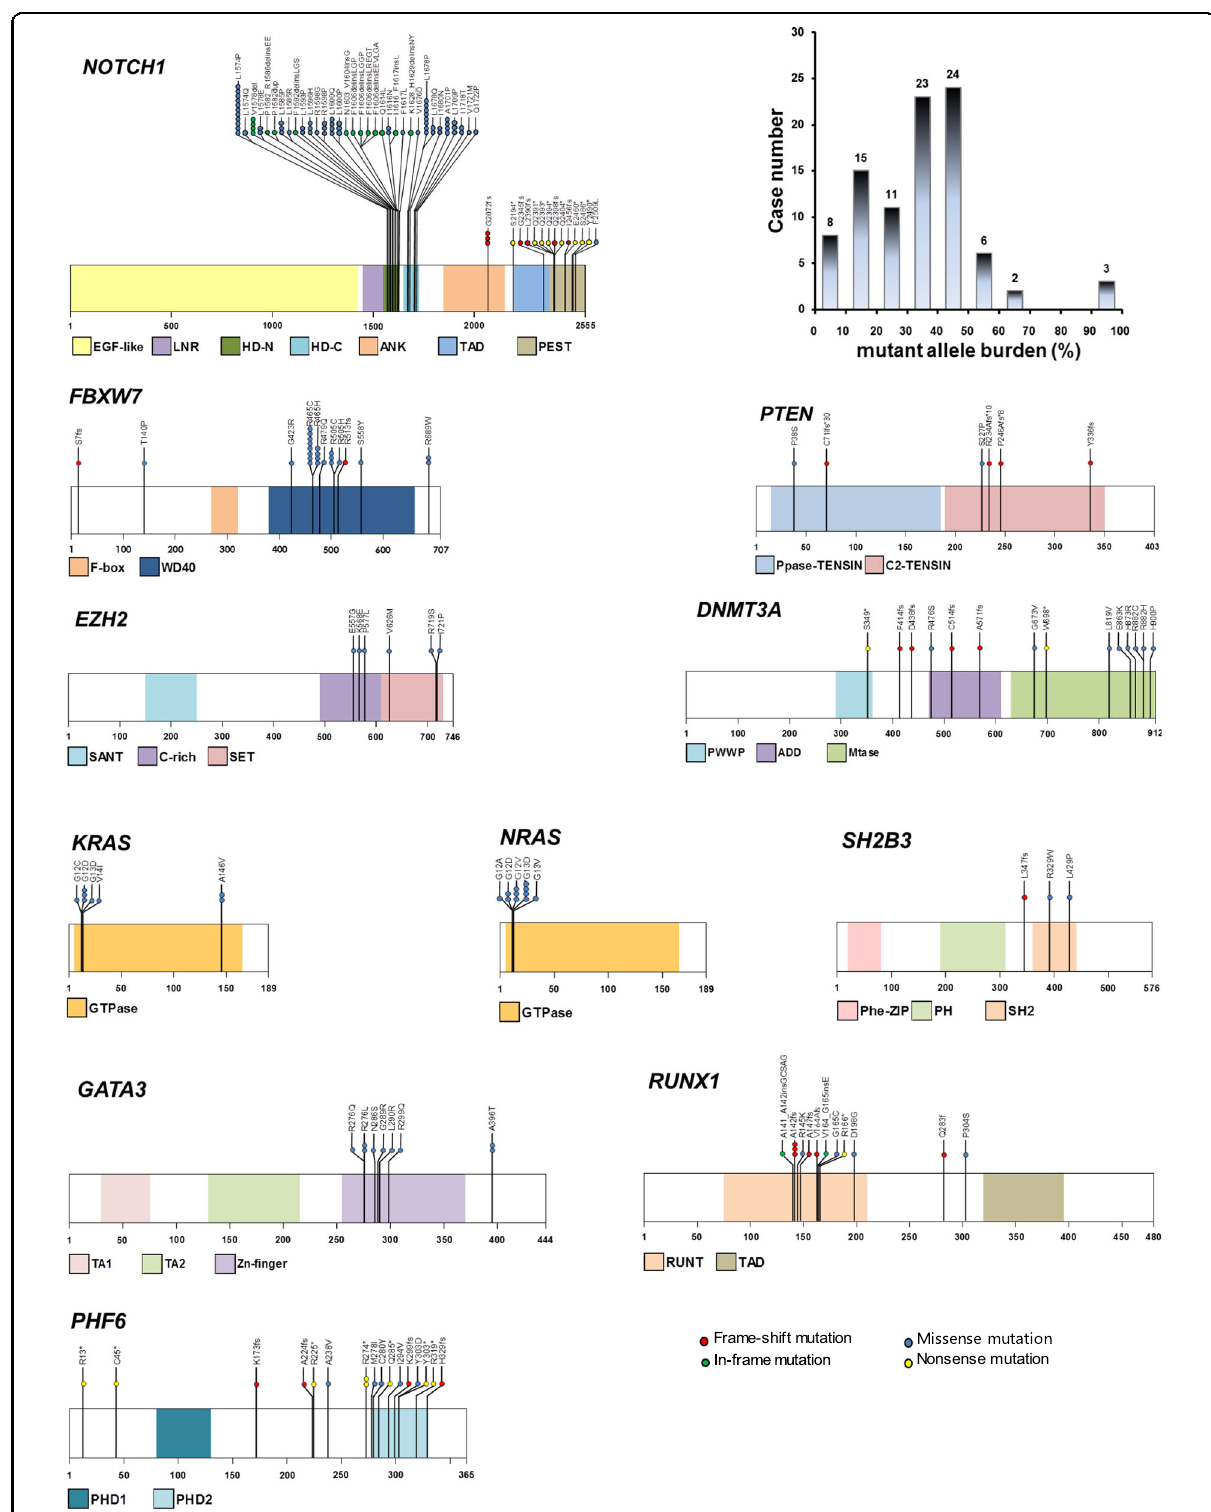
Fig. 2 Sequence mutations for 11 molecular markers in our T-ALL cohort. The frequency of the obtained mutations is illustrated by the number of colored circles, which also indicate the effect at the amino acid level. The histogram presents the distribution of the NOTCH1 mutant allele level detected in our T-ALL cases. The schematics are based on the following NCBI protein reference sequences: NOTCH1 , NP_060087.3; FBXW7 , NP_361014.1; PTEN , NP_000305.3; EZH2 , NP_004447.2; DNMT3A , NP_072046.2; KRAS , NP_ 203524.1; NRAS , NP_002515.1; SH2B3 , NP_005466.1; GATA3 , NP_001002295.1; RUNX1 , NP_001745.2; and PHF6 ,